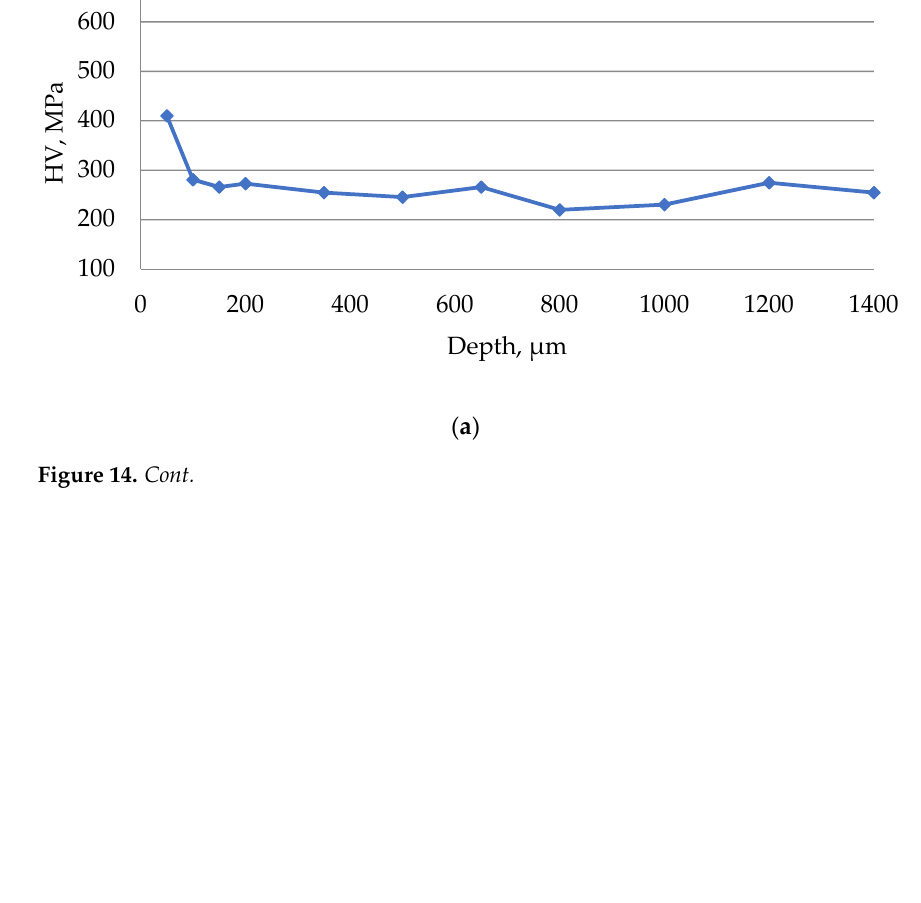
Figure 13. Surface structure of steel 15 at 100× magnification after EDM in rough ET mode from: ( a ) copper; ( b ) graphite; ( c ) composite.